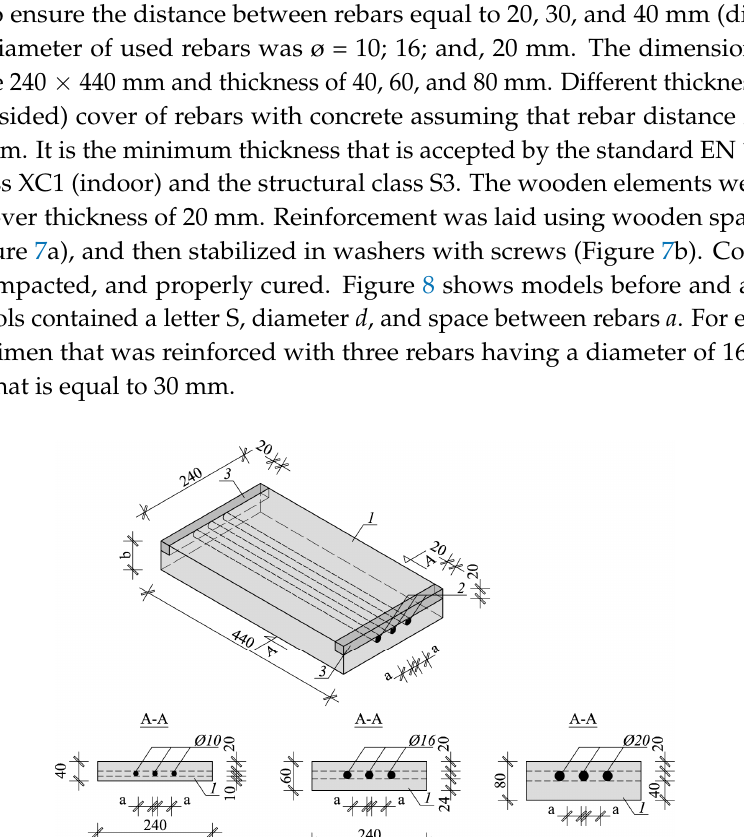
Figure 5. Tested elements with the reinforcement broken down at its ends.